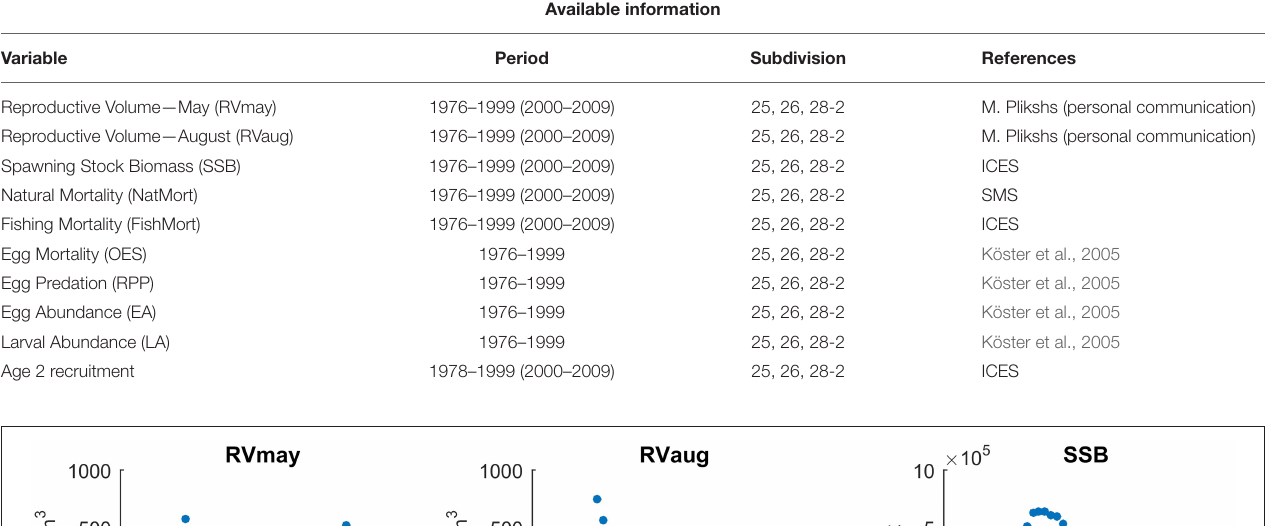
TABLE 1 | List of variables applied to the models.